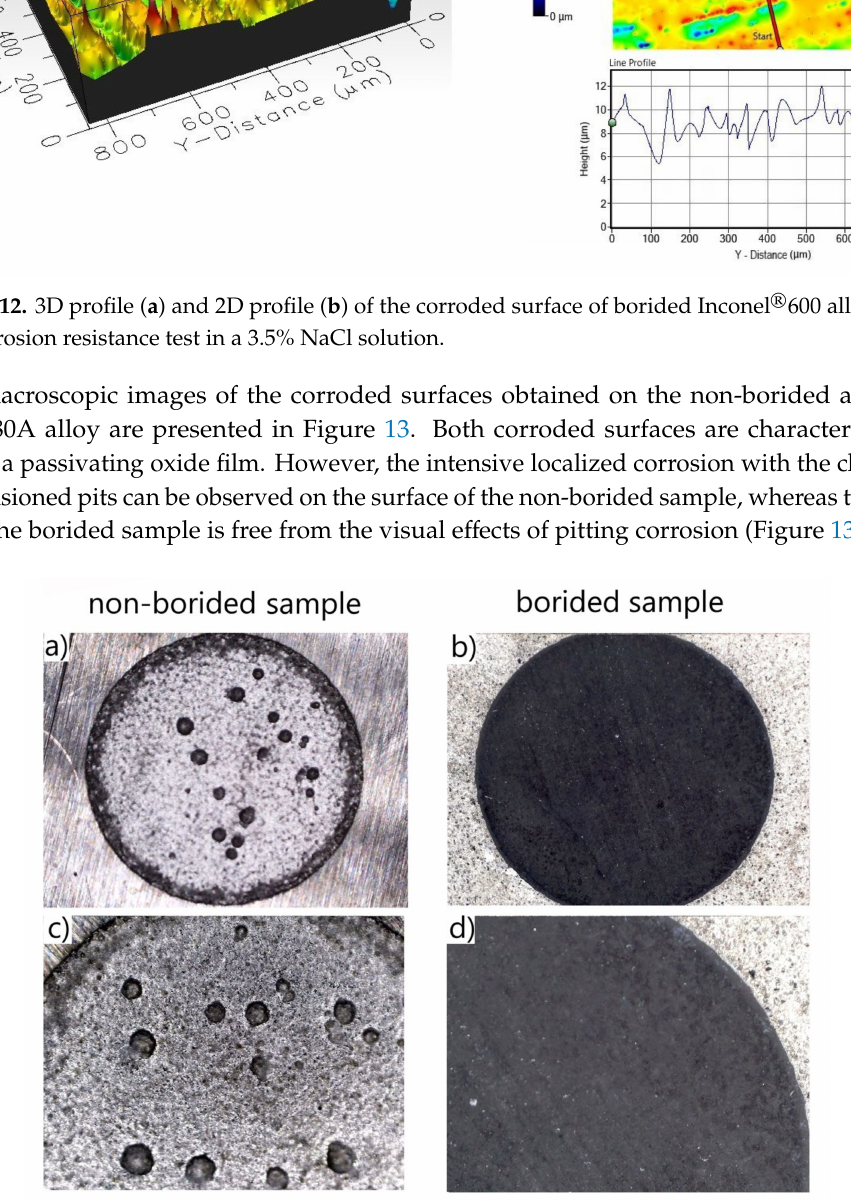
Figure 13. Macroscopic images of the corroded surface of the non-borided ( a , c ) and borided ( b , d ) Nimonic ® 80A alloy after corrosion resistance test in a 3.5% NaCl